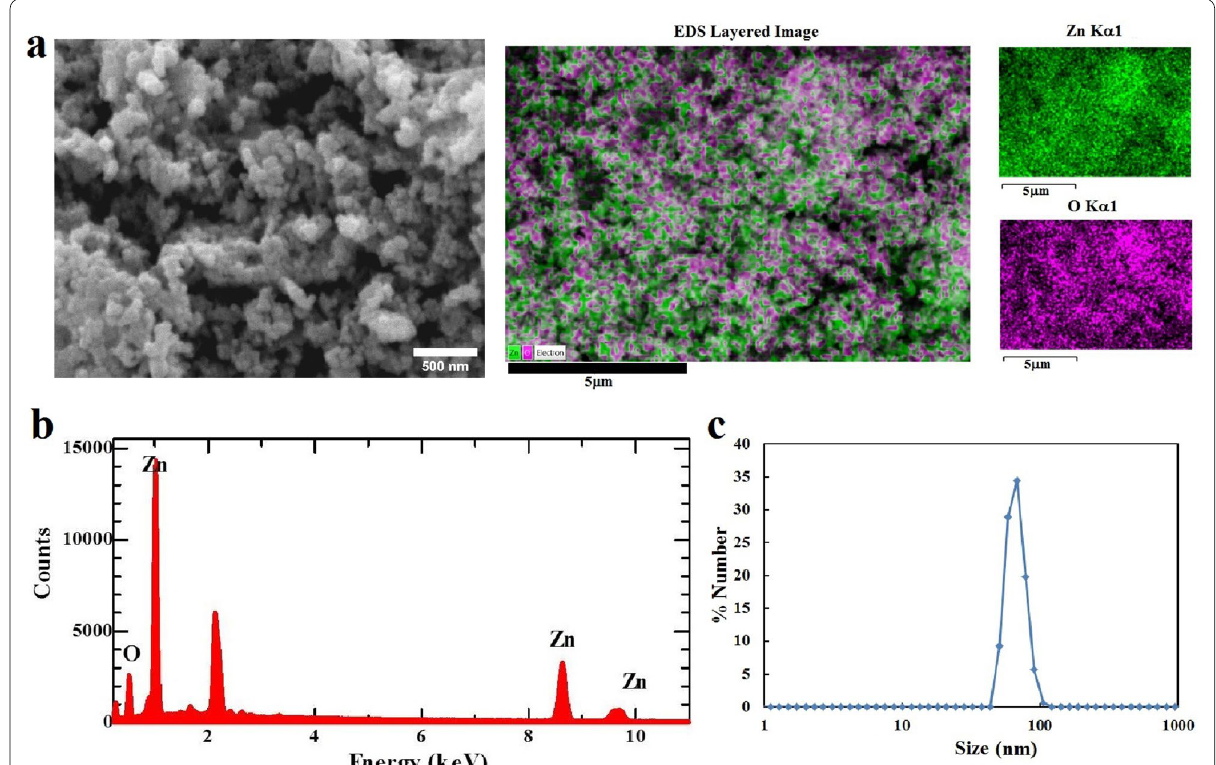
Fig. 2 a SEM image and EDX mapping, b EDX spectra and c size distribution curve of ZnO NPs